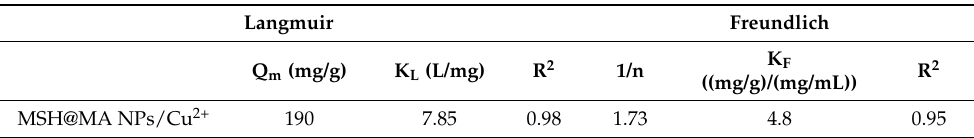
Table 3. Comparison of the adsorption capacity of the various functional adsorbent materials. Type of Adsorbent